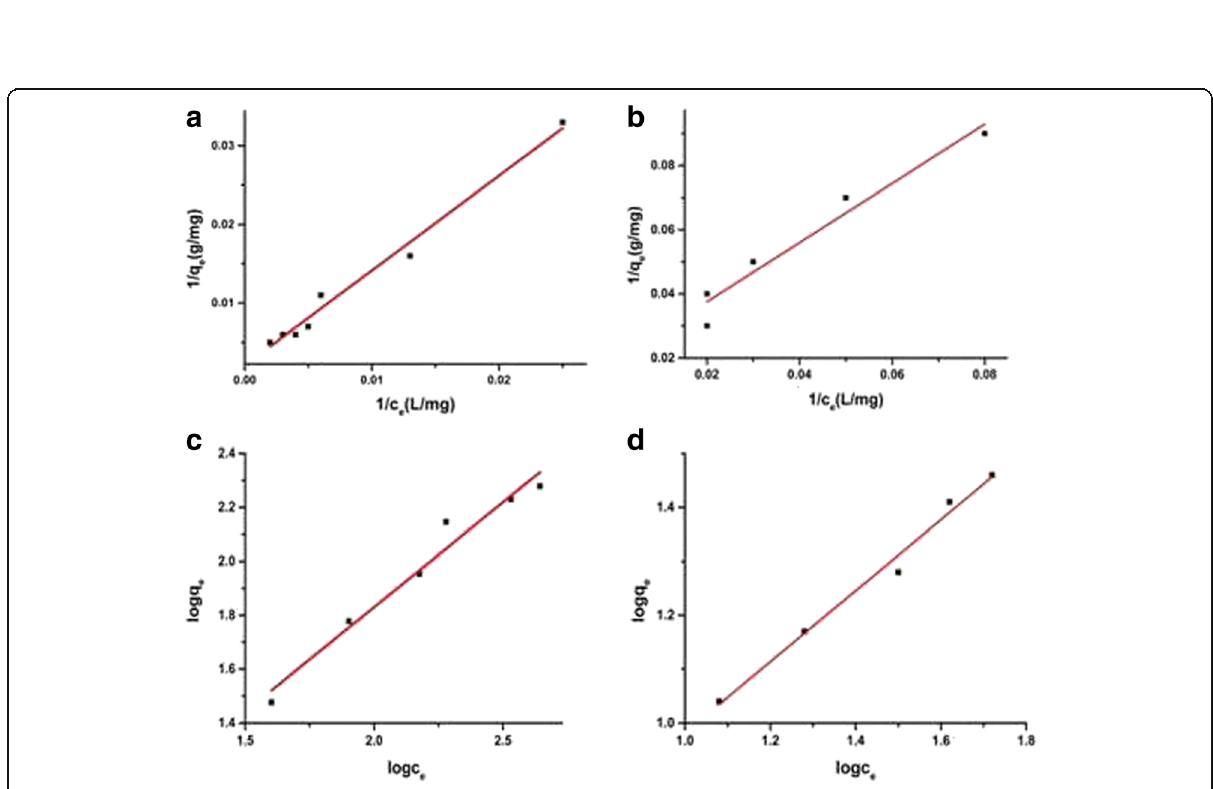
Fig. 6 ( a , b ) Langmuir adsorption isotherms and ( c , d ) Freundlich adsorption isotherms for MB and aniline removal